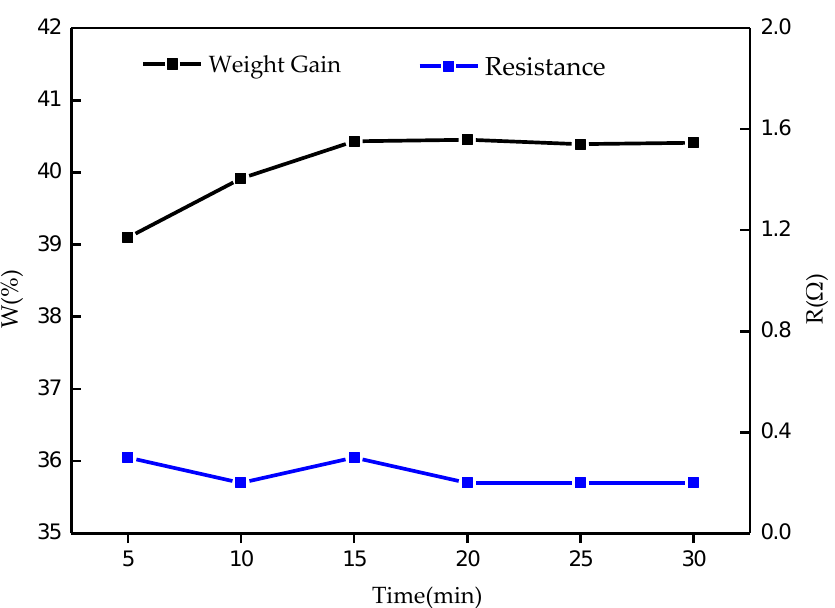
Figure 3. Effect of Ag-deposition time on the resistance and weight gain of the modified cotton. FTIR is a useful technique for the study of the functional groups of materials. For the infrared spectrum of the pristine cotton presented in Figure 4, a relatively broad absorp- tion peak around 3350 cm −1 is the characteristic peak of OH on the cotton surface and the absorption peaks at 1161 cm −1 and 1109 cm −1 are the characteristic peaks of C-O-C in the cotton chemical structure. Compared to the spectrum of the original cotton, a new peak appears at 1730 cm −1 in the spectrum of the modified cotton that is attributed to the stretch- ing vibration peak of the carbonyl group (C=O), indicating that methacryloxyethyltrime- thyl ammonium chloride (METAC) has been successfully grafted onto the surface of the cotton.